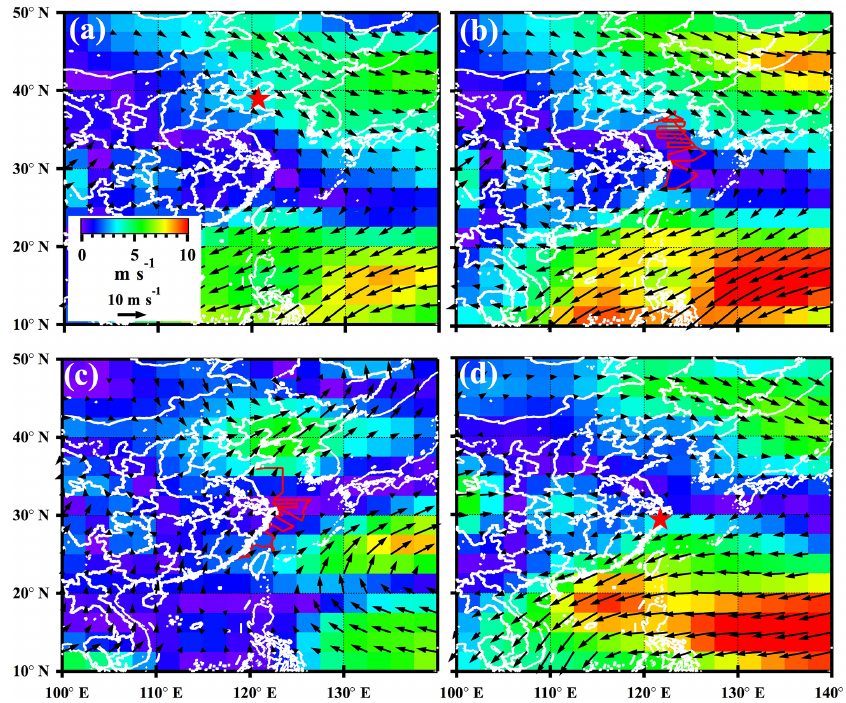
Figure 2. The synoptic wind flow patterns at 925hPa averaged over Changdao Island ( a , red star, 20 March–24 April), the first cruise ( b , red line, 17 March–9 April), the second cruise ( c , red line, 28 May–8 June), and Wenling ( d , red star, 1–28 November) campaign periods as shown in Fig. 1. The arrow length and color show the wind speed, while the arrowhead indicates the wind direction.